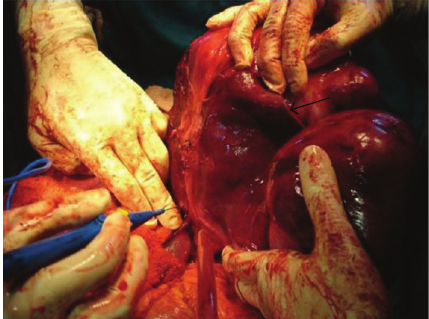
Figure 1: CECT abdomen showing the lesion.